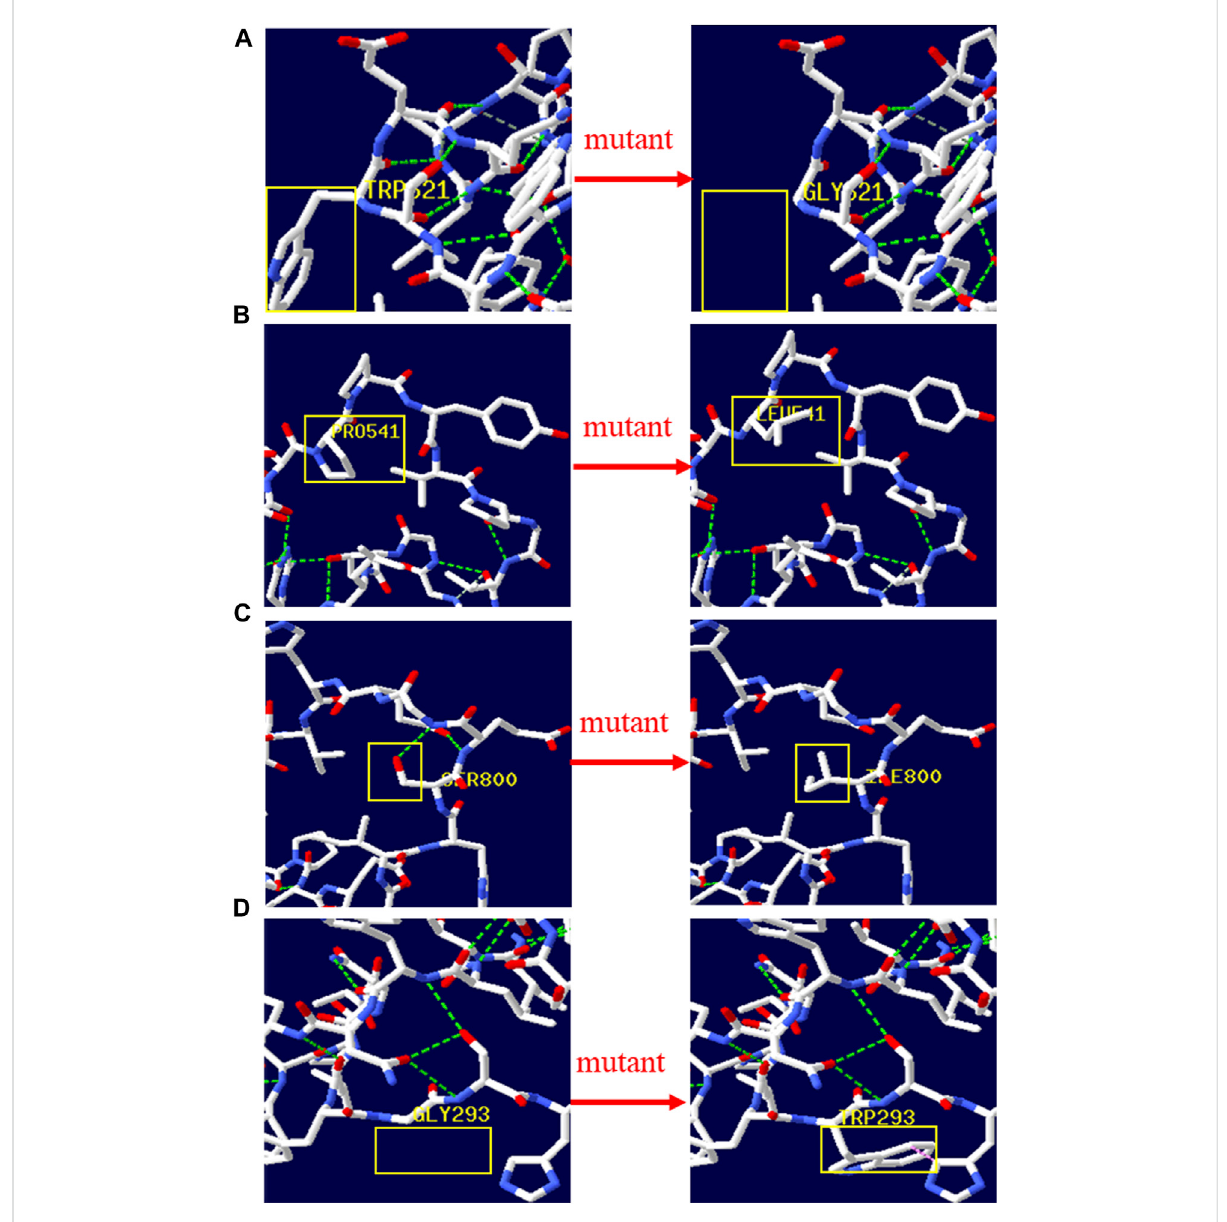
FIGURE 1 3D structure of wild type and mutant type of novel variants in GAA. The yellow boxes marked the sites of wild-type Gly293, Prp541, Trp621, Ser800 and mutated Gly621, Leu541, Ile800, Trp293. The 3D protein structures of novel variants in GAA gene were predicted by Swiss-Pdb Viewer 4.1 indicating the missense mutations might affect the proteins function via destroying hydrogen bonds, or conformational constraints which resulted in the proteins into disordered extended